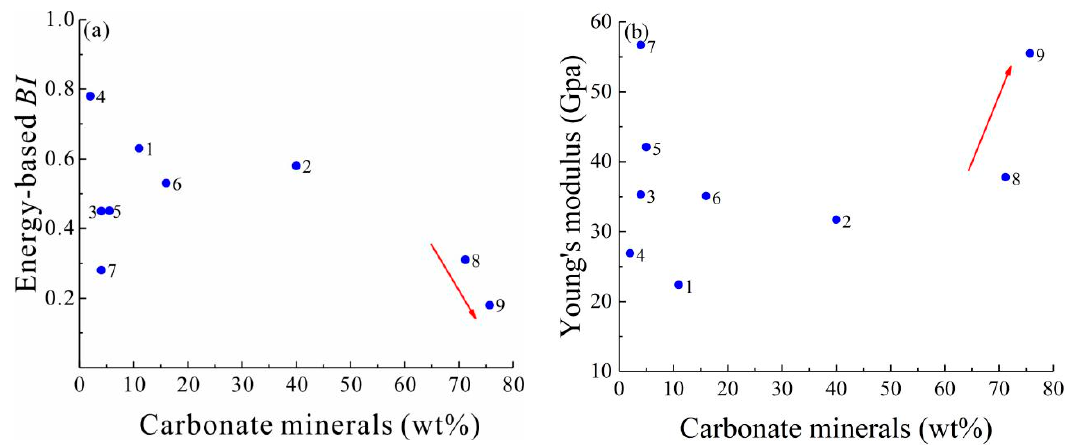
Figure 13. ( a ) Relationship between energy-based BI and carbonate mineral content; ( b ) Relationship between Young’s modulus and carbonate minerals content.